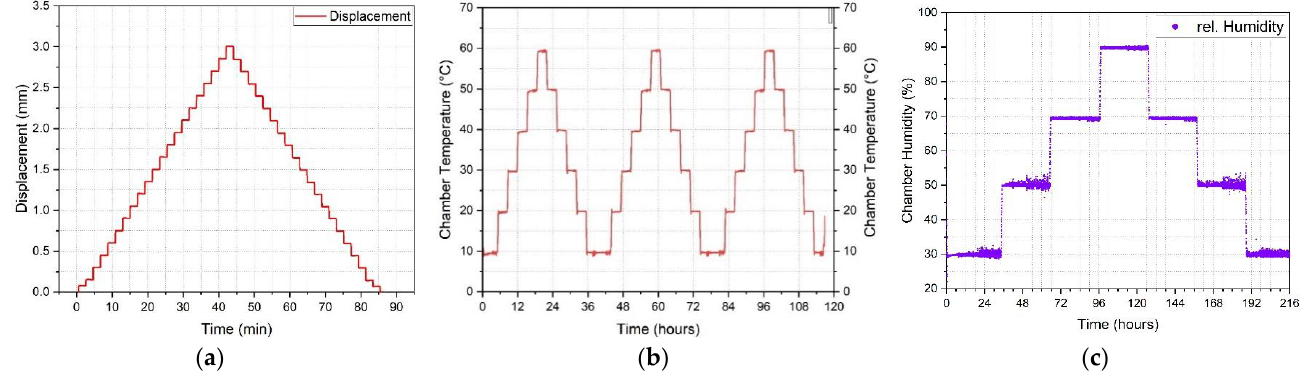
Figure 3. ( a ) displacement cycle 0 – 3 – 0 mm (0 – 2000 με) for strain calibration tests ( b ) heating and cooling cycles (10 – 60 – 10 °C) for temperature calibration tests and ( c ) relative humidity cycle (30 – 90 – 30%) for humidity calibration tests.